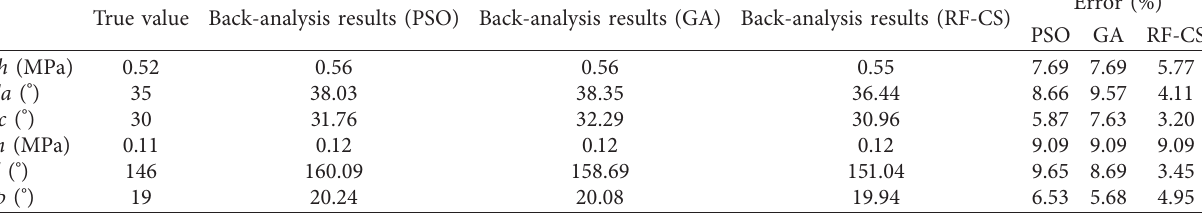
Table 7: Comparison of back-analysis results.